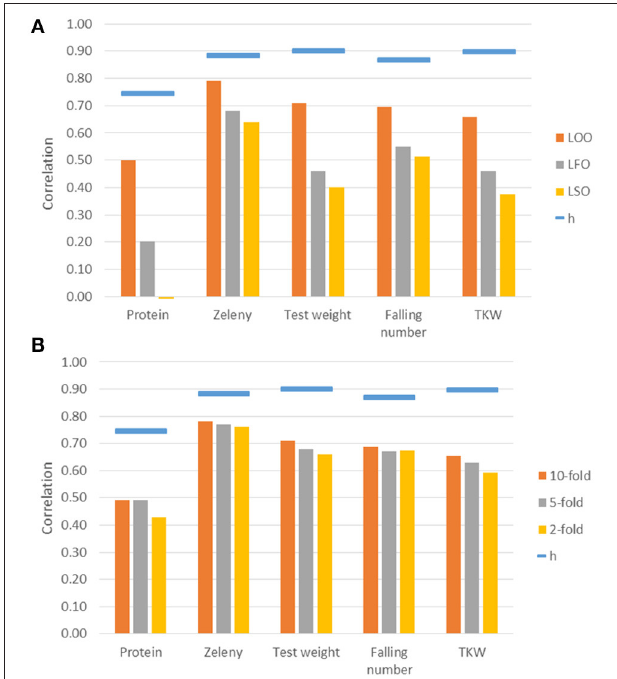
FIGURE 7 | Correlations between observed phenotypes corrected for fixed effects and GEBVs based on the GBLUP models. Maximum correlation, h, is the square root of the narrow sense genomic heritability and is shown as blue bars over the correlations. Correlations are based on different kinds of cross-validations. (A) Leave-One-Out, Leave-Family-Out, Leave-Set-Out, and (B) k-fold